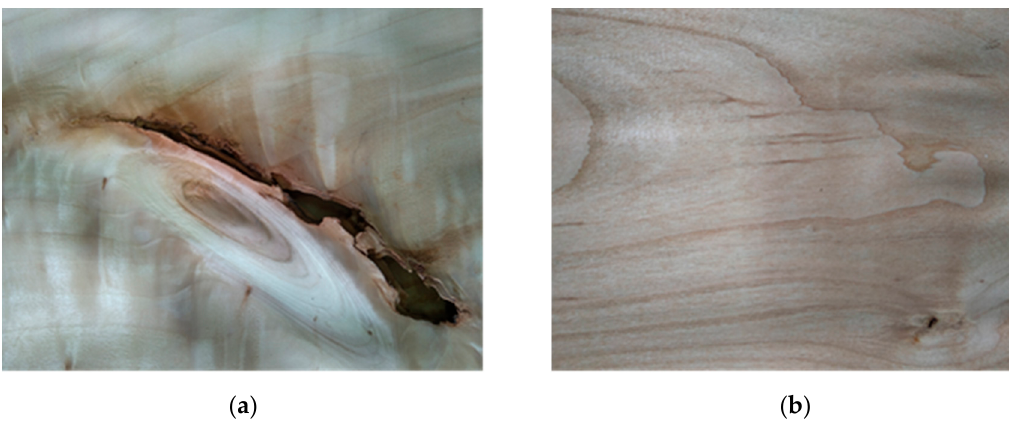
Figure 2. Ash wood sliced veneer with discoloration and irregularities of annual rings ( a ), and live internal knot with spiral grain around the knot ( b ).